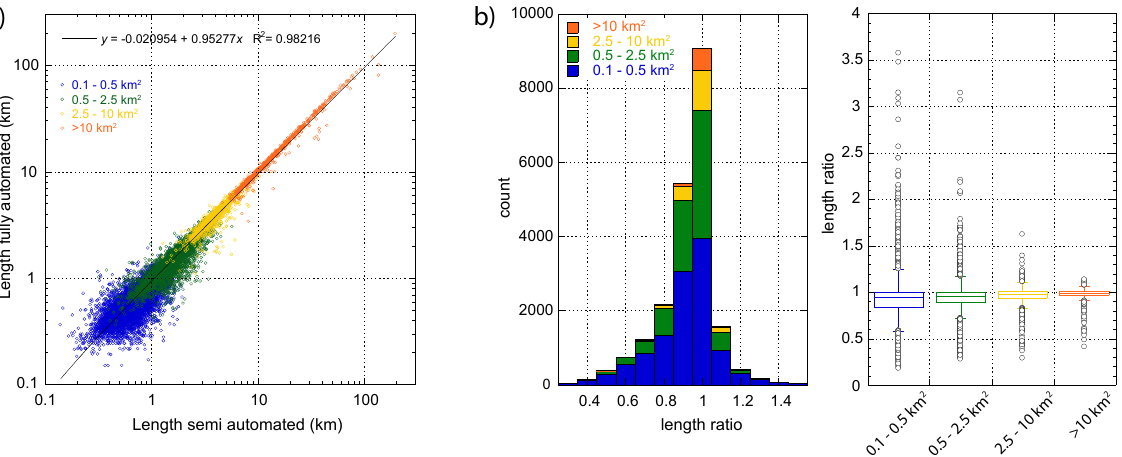
Figure 7. (a) Linear regression of glacier length for all Alaskan glaciers determined in an automated way ( L a , using the approach presented here) and a semi-automated approach ( L k , Kienholz et al., 2014). (b) Length ratio L a /L k displayed for four glacier size classes (cf. Fig. 9 in Kienholz et al., 2014) in a histogram and box plots. Whiskers in the latter refer to 1.5 interquartile range.